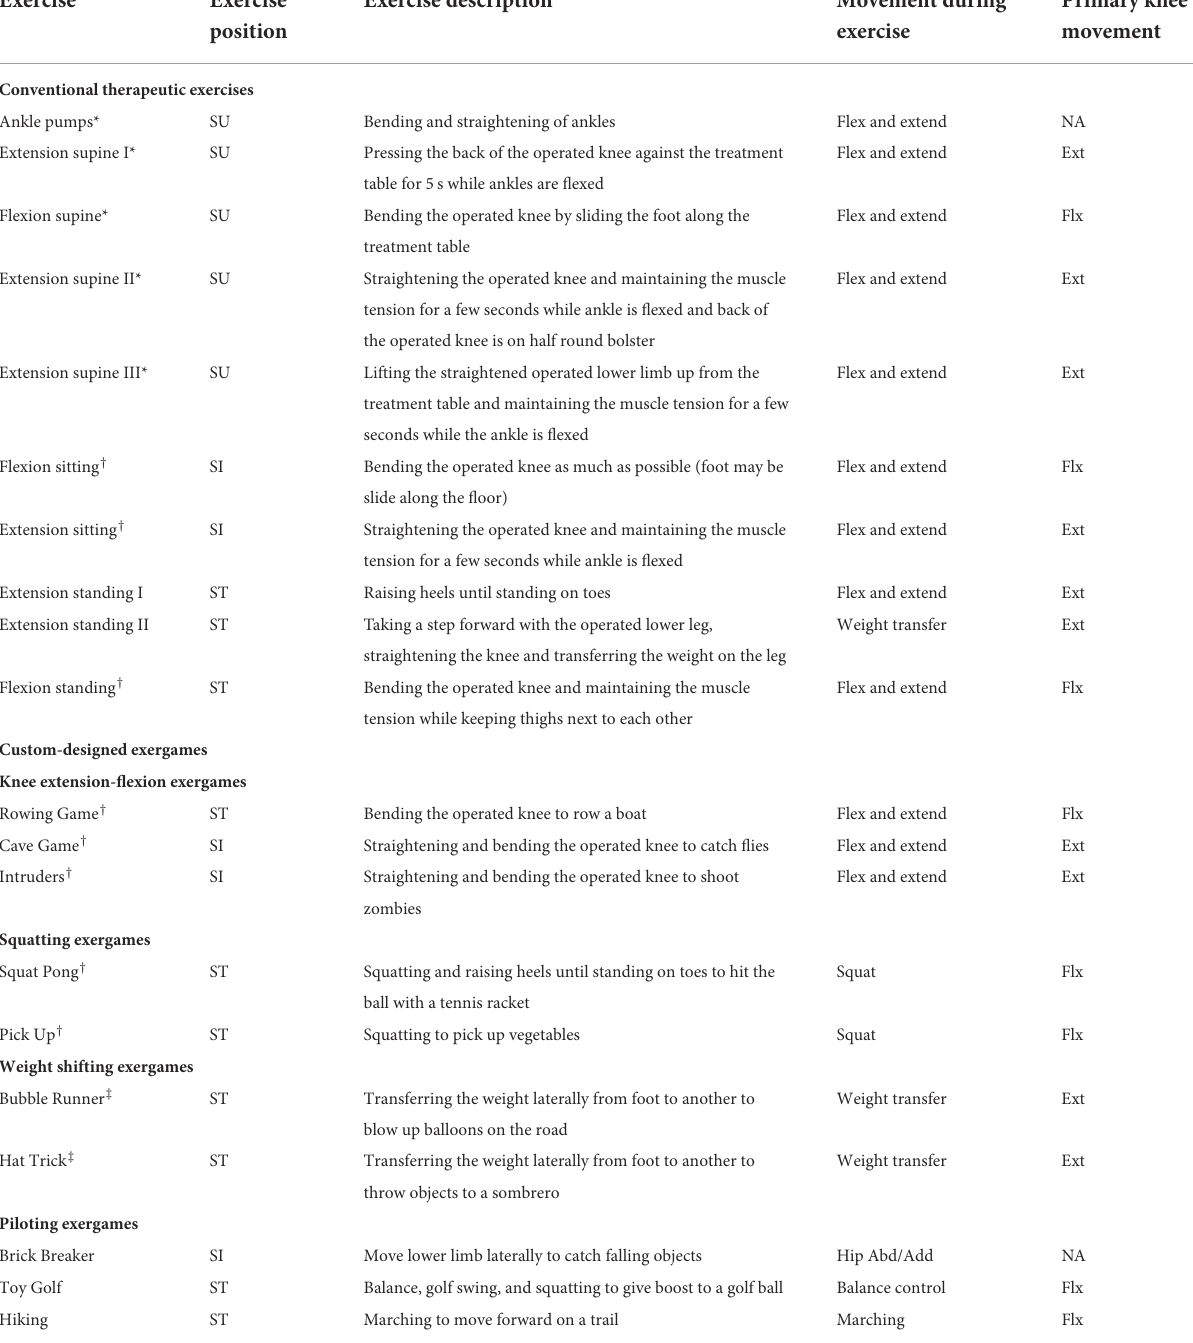
TABLE 2 Exercise protocols used in the study: (1) conventional therapeutic exercises and (2) custom-designed exergames.